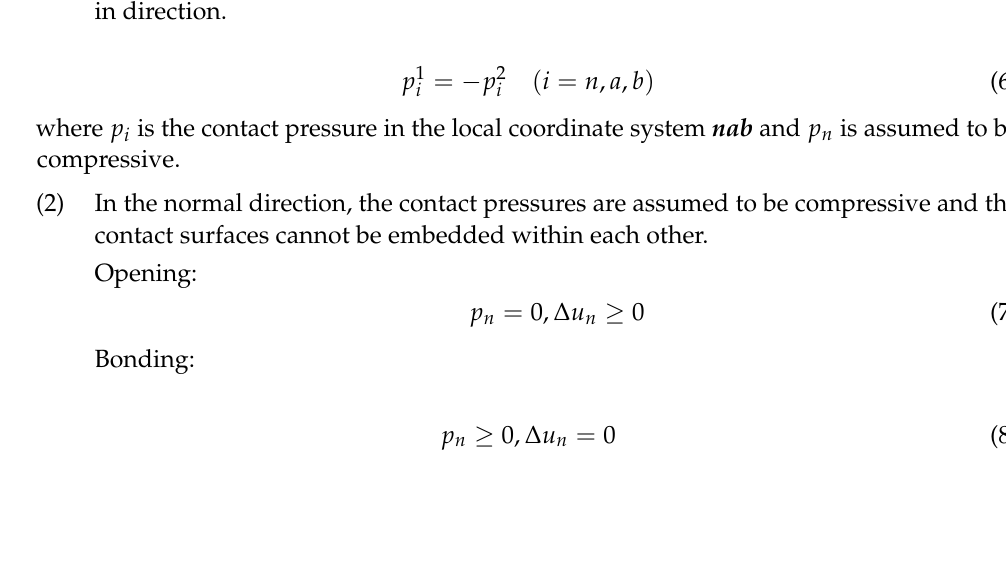
where p i is the contact pressure in the local coordinate system nab and p n is assumed to be compressive. In the normal direction, the contact pressures are assumed to be compressive and the contact surfaces cannot be embedded within each